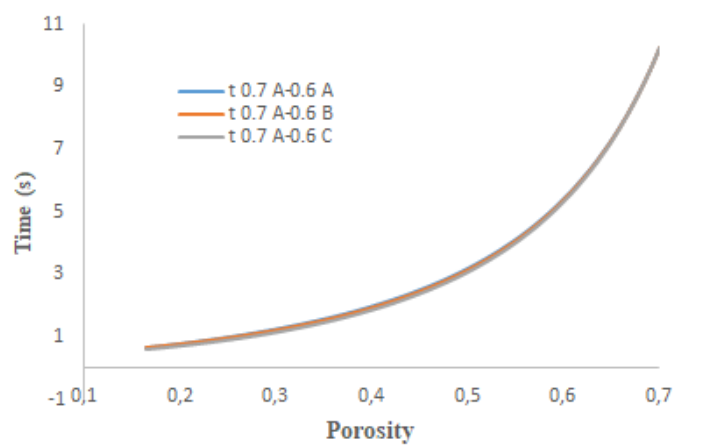
Figure 7. The effect of material porosity on time for temperature change (S)